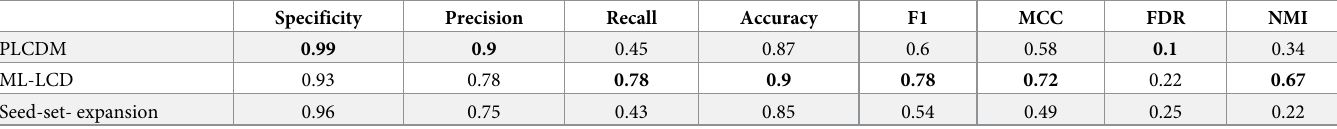
Table 4. Assessing PLCDM using the Multilayer2 data.